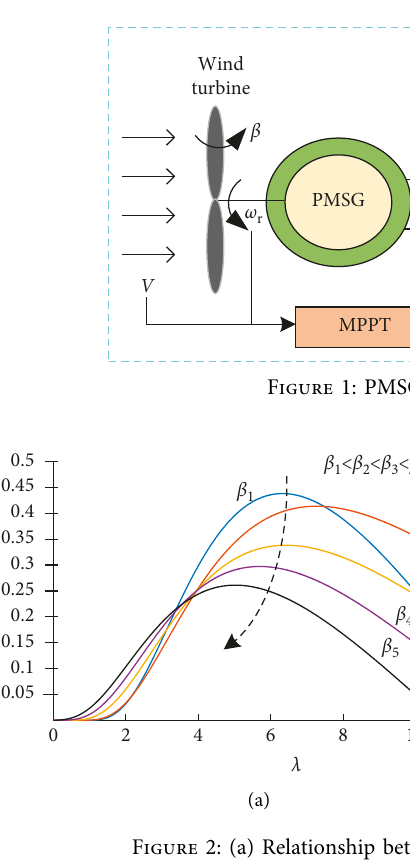
p and λ and (b) relationship between